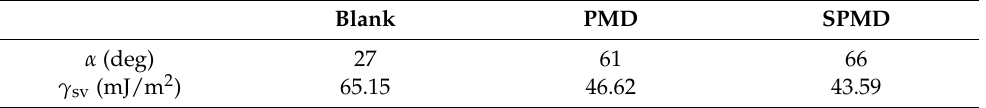
Table 4. Obtained α and γ sv values for samples exposed to SCP without and with 0.12 mM PMD and SPMD.